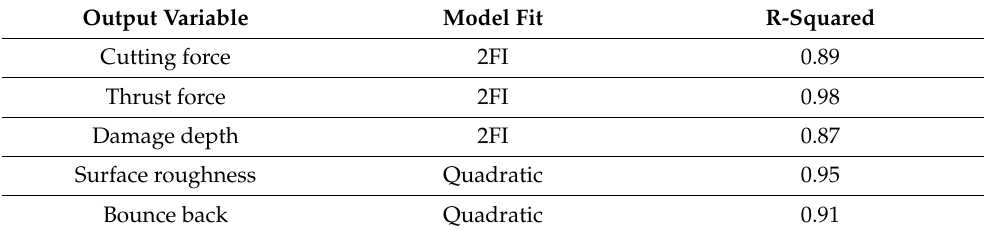
Table 6. Models’ summary statistics.